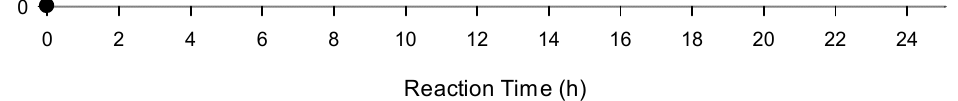
Figure 9 . Effect of reaction time on the transesterification of WFO using NSh ‐ HZSM5 catalyst at of 10 wt % catalyst loading, Figure 9. Effect of reaction time on the transesterification of WFO using NSh-HZSM5 catalyst at of 10 wt % catalyst loading, methanol to WFOs molar ratio of 12:1,180 °C, and 550 rpm . methanol to WFOs molar ratio of 12:1,180 ◦ C, and 550